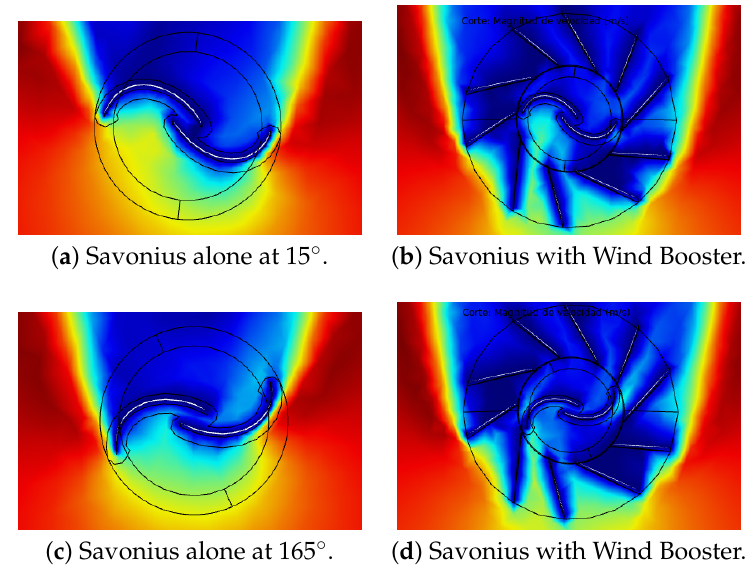
Figure 14. Wind flow behavior at 2.04